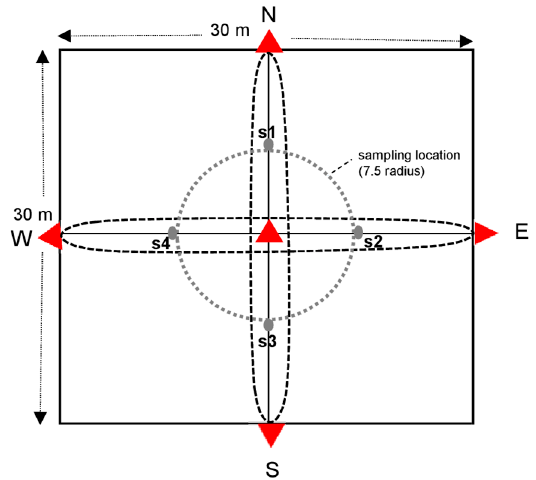
Figure 2. Field sampling set up. The red triangles are demarcations for site central position and transect radii (North, East, South, and West). The grey dots are mid-positions of transect radii from the site’s central location and provide sampling locations (s1, s2, s3 and s4).